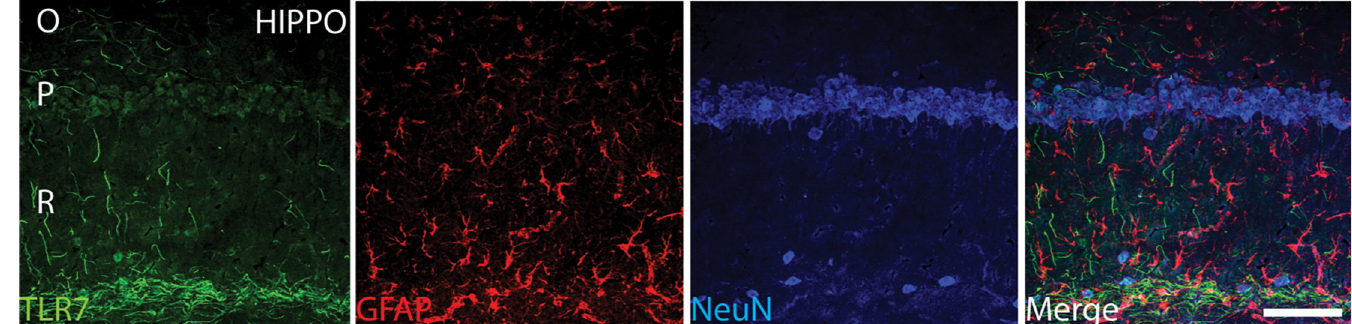
Fig 5. The expression of TLR-7 in the hippocampal brain region. The immunofluorescence of TLR7 recognized by Alexa 488, green. GFAP recognized by Alexa 594, red. NEUN recognized by Alexa 633, (blue) and merged image in the hippocampal region. NeuN and GFAP were applied to show the distribution of TLR7 within neuronal and supportive tissue populations. Scale bar 80 μ